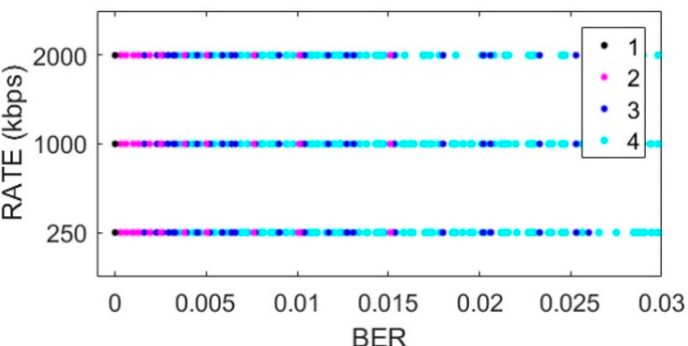
Figure 3. Scatterplot of transmission rate against BER.